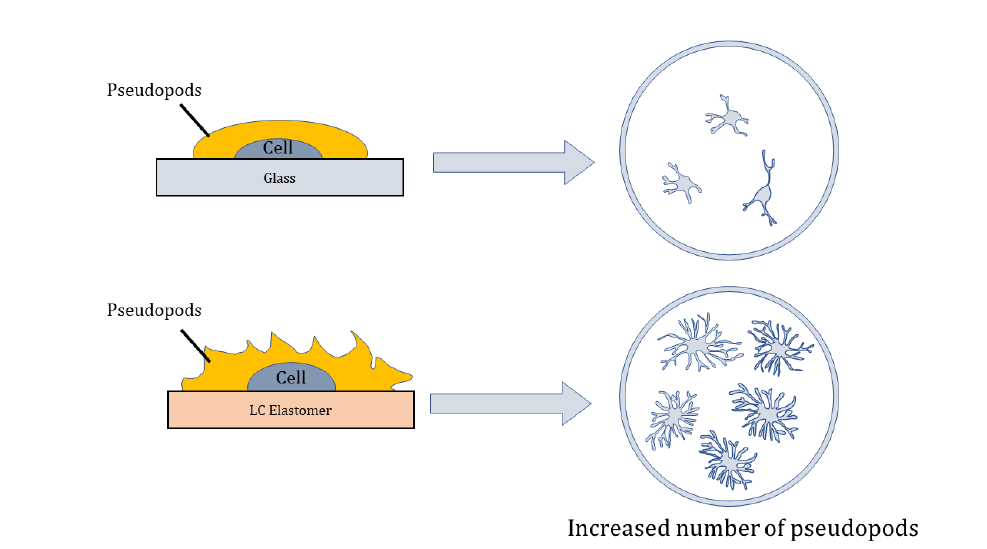
Figure 12. An illustration demonstrating the biocompatibilty of the cholesterol-based elastomers with the tissue cultures and the resulting tissue samples. The LC content on the surface of the substrate helps the cells adhere, which results in the higher density of pseudopods